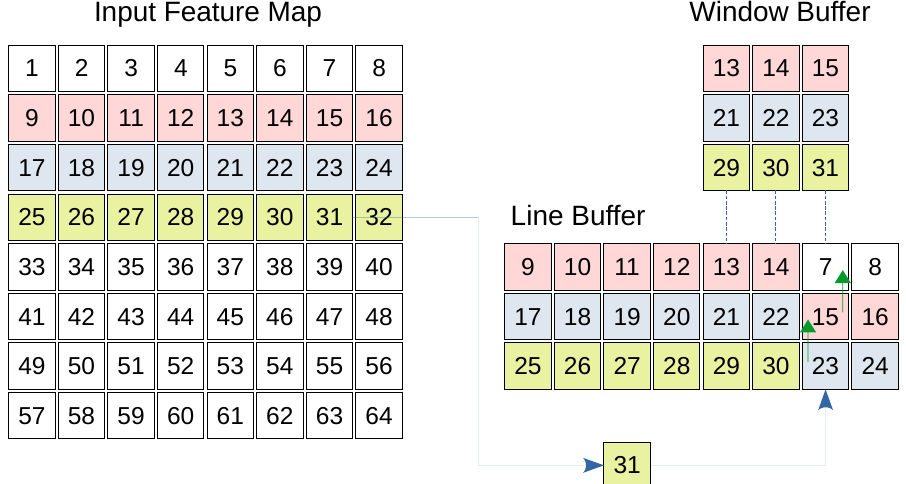
Figure 4. Line buffer and window buffer architecture. This figure illustrates an example of a single line buffer and a single window buffer for a single input feature map. In this example, the 4th line of the input feature map is being streamed value by value to the line buffer. Specifically, the input value 31 is streamed from the input feature map to the appropriate location in the line buffer. The old values (23 and 15) in the line buffer are shifted up to the appropriate places in their original lines, while the old value 7 is no more needed. The window buffer copies the set of line buffer values that correspond to the current operation (convolution or